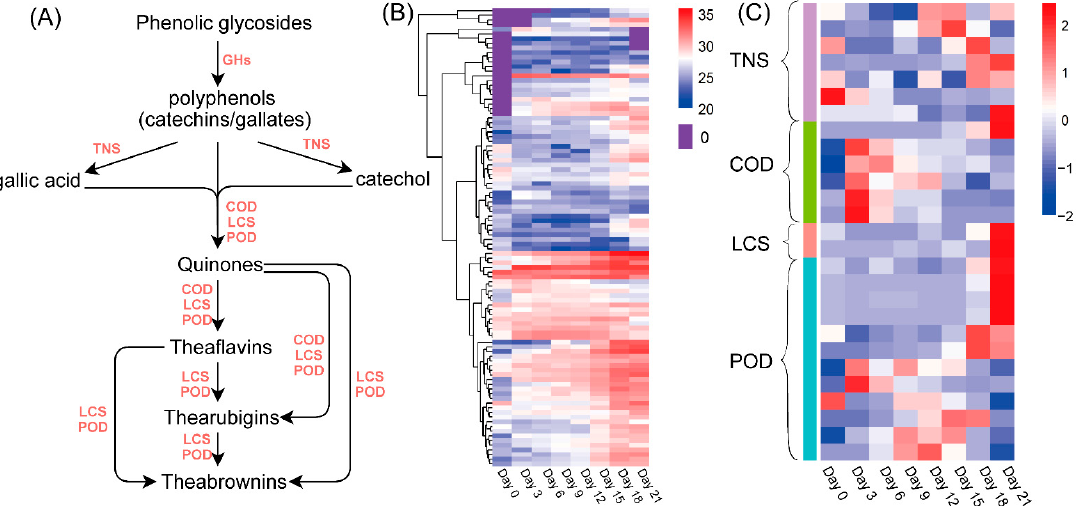
Figure 5. The hypothetical metabolic pathway of tea phenols ( A ), and the abundance heatmap of related enzymes: heatmap of GHs ( B ), and heatmap of TNS, COD, LCS and POD ( C ). GHs, glycoside hydrolases; TNS, tannase; COD, catechol oxidase; LCS, laccase; POD, peroxidase.